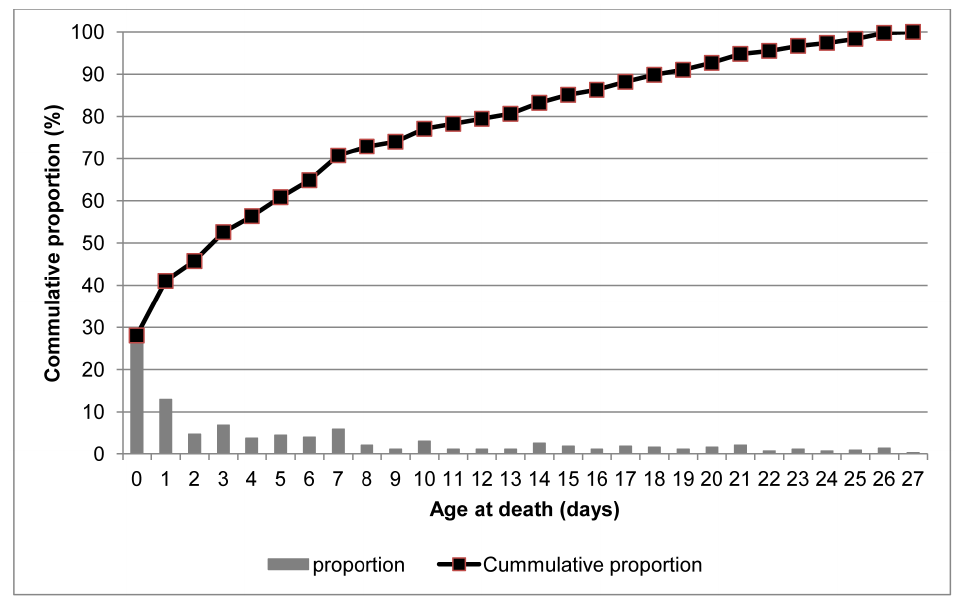
Figure 4. Timing of neonatal deaths in Navrongo HDSS: 2003–2009.